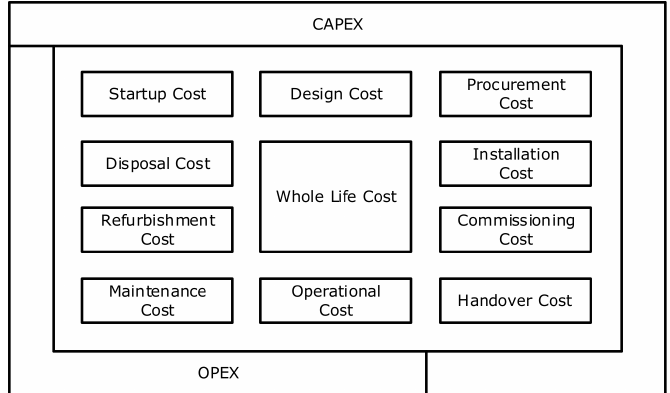
Figure 1. Whole Life